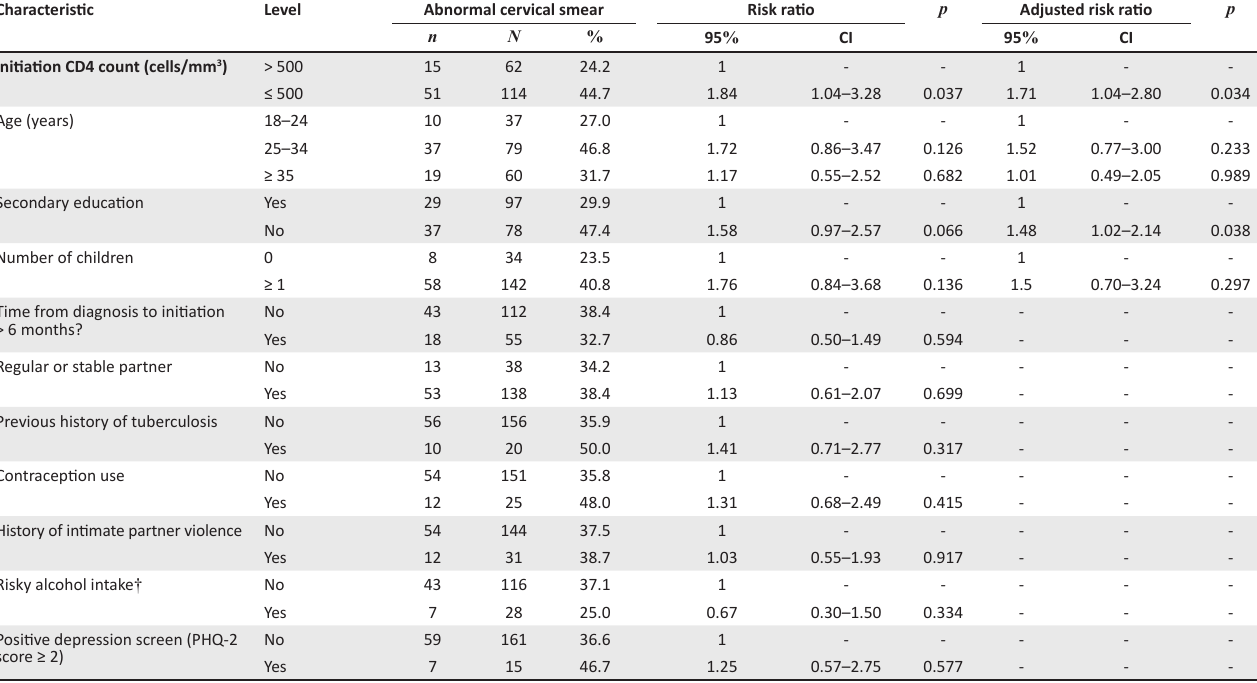
TABLE 2: Associations between socio-demographic variables, initiation CD4 count and abnormal cervical smear results ( n = 176). 5